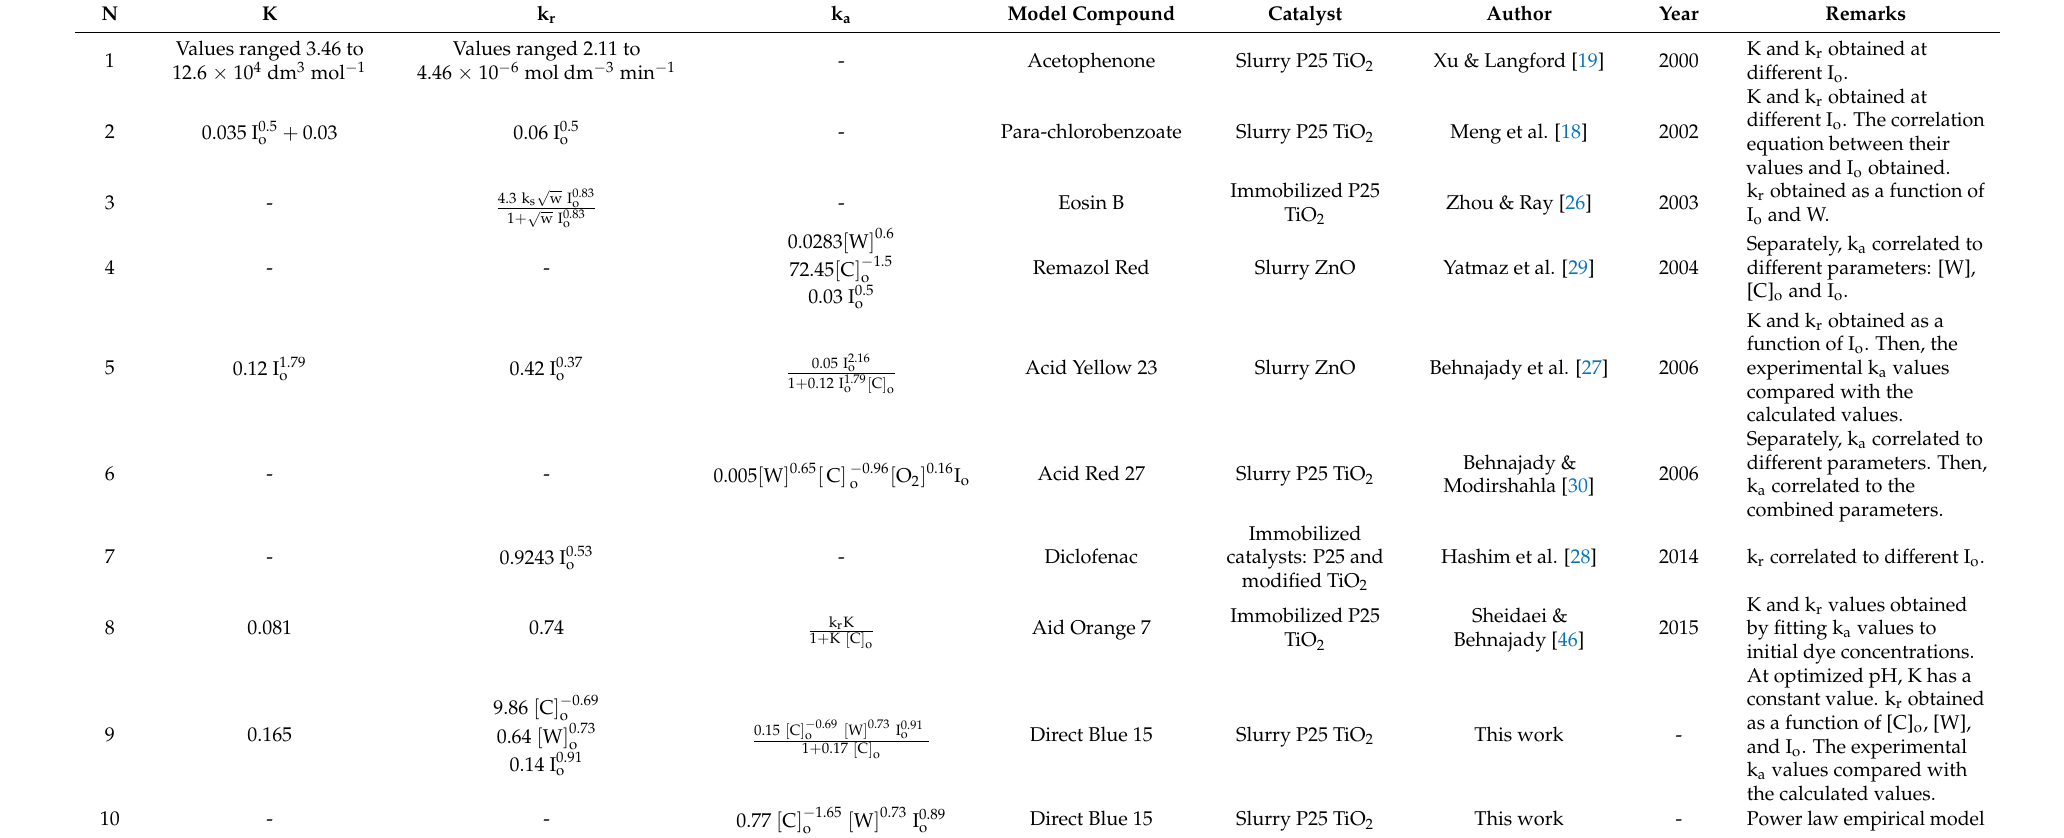
Table 7. Some available k a , K and k r models in the relevant literature in comparison with the obtained kinetic models. N K k r k a Model Compound